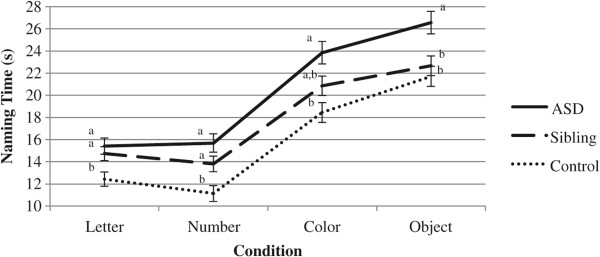
Line graph of condition by group interaction for naming time. Groups with different superscripts differ at p < .05.